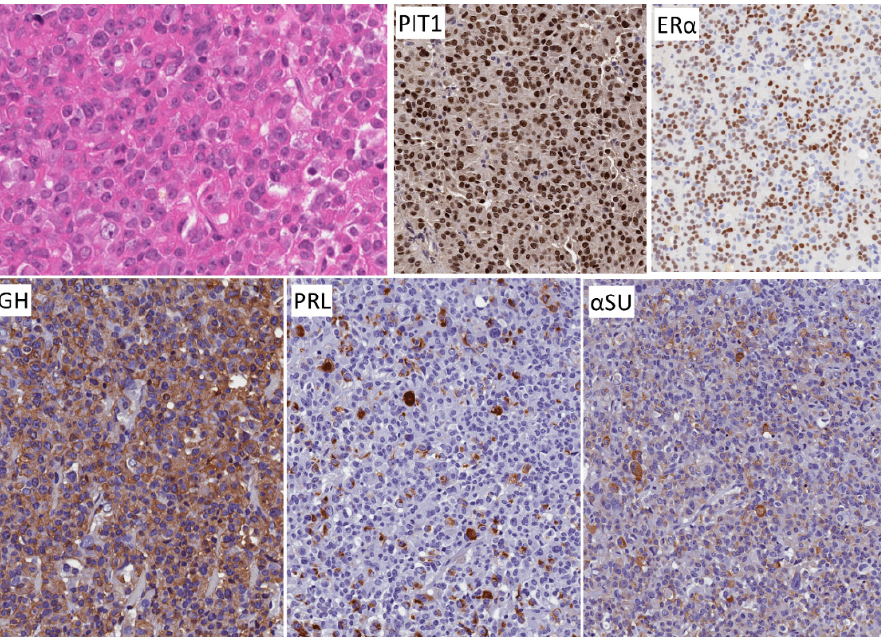
Figure 5. Morphology of mammosomatotroph tumor. These tumors resemble densely granulated somatotroph tumors (compare with Figure 1). They are composed of sheets or nests of strongly acidophilic cells that stain for PIT1, GH and α SU but in addition, they express nuclear ER α and have variable cytoplasmic positivity for prolactin (PRL).